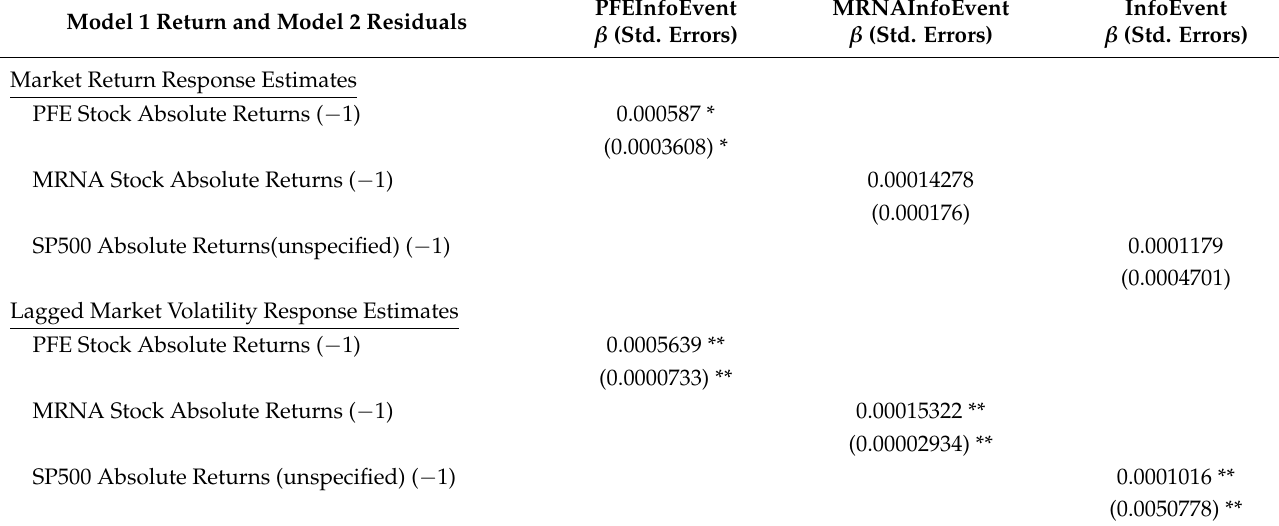
Table 4. Index/Stock Returns and Volatility Responses to Information